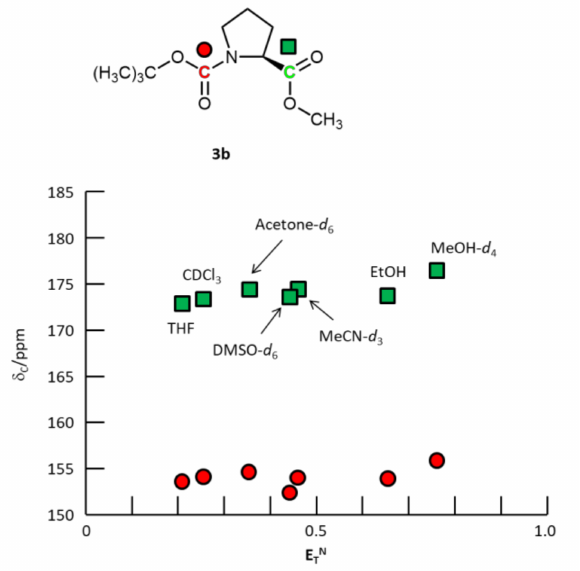
Figure 7. 13 C NMR chemical shifts of the carbonyl carbons of N -Boc-L-proline-OMe 3b